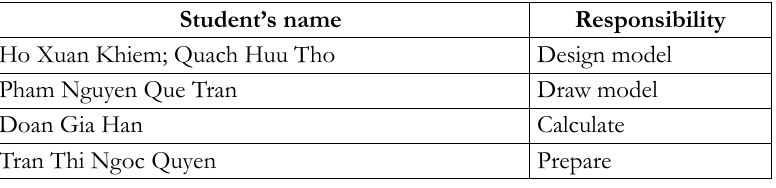
Table 2. Worksheet 1. Specific tasks to members of Group 1